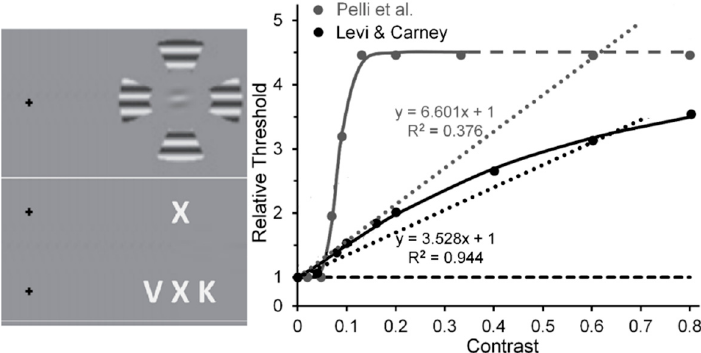
Figure 5. ( Left panel ): ( upper ) Gabor-target and flanker stimuli used by Levi & Carney; ( lower ) letter target and flanker stimuli used by Pelli et al. ( Right panel ): Threshold elevation as a function of flanker contrast. Data points for both studies are accompanied by best fitting Naka-Rushton functions; dotted lines are best fitting linear functions. A dashed line extrapolates the Naka-Rushton function for Pelli et al.’s results beyond their highest Michelson contrast of 0.33. Adapted from [59] and from [60] with permission from the publishers.